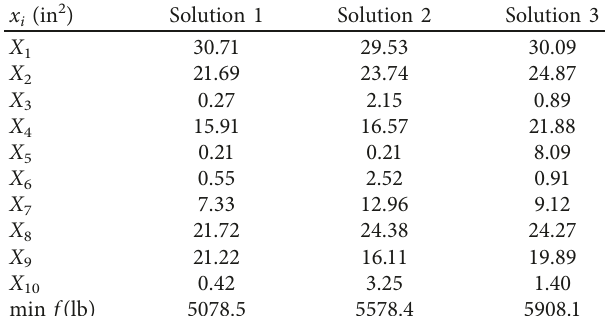
Figure 10: Ten-bar truss. Table 2: Results with MGA.